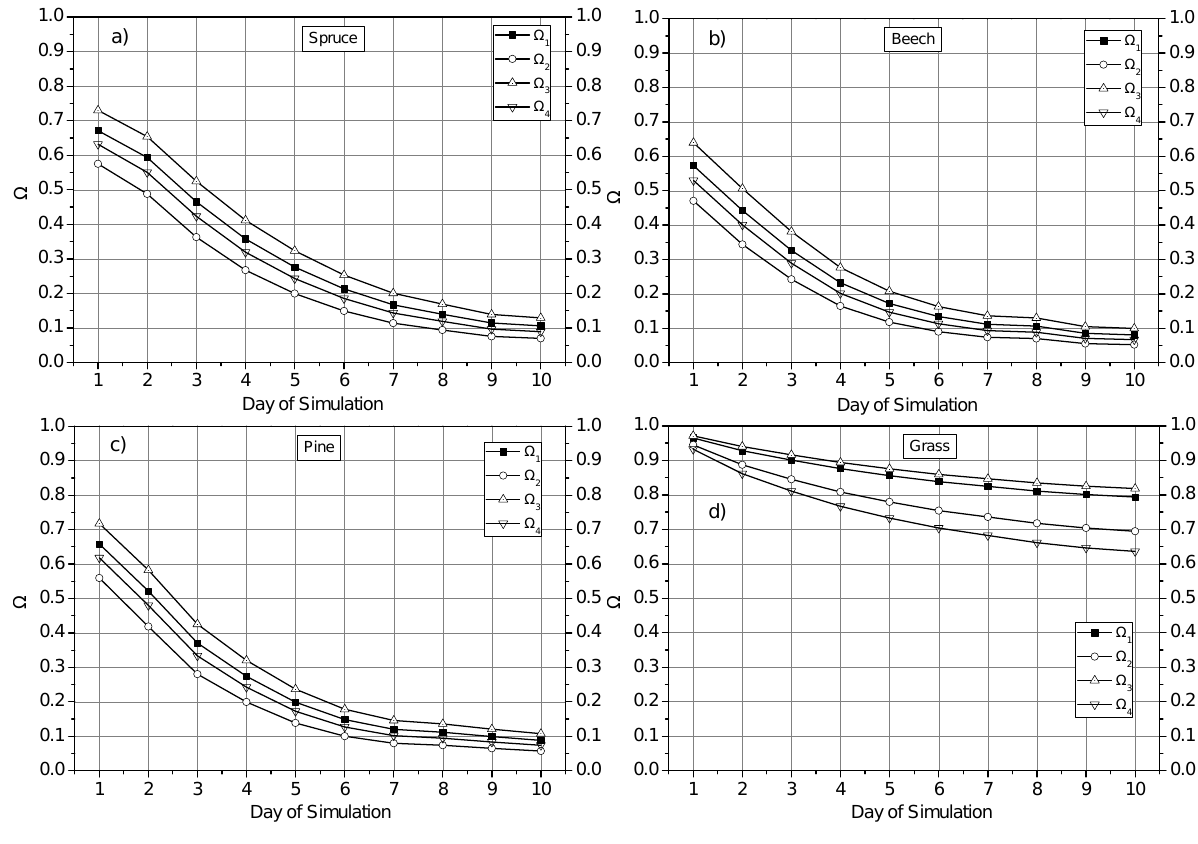
Fig. 14. Decoupling coefficients using four different approaches (Mean of 15min values between 10:00 and 15:00LT) during a summery dry period. HIRVAC simulations for spruce (a) , beech (b) , pine (c) and grass (d) with the stand parameters as described in Fig.